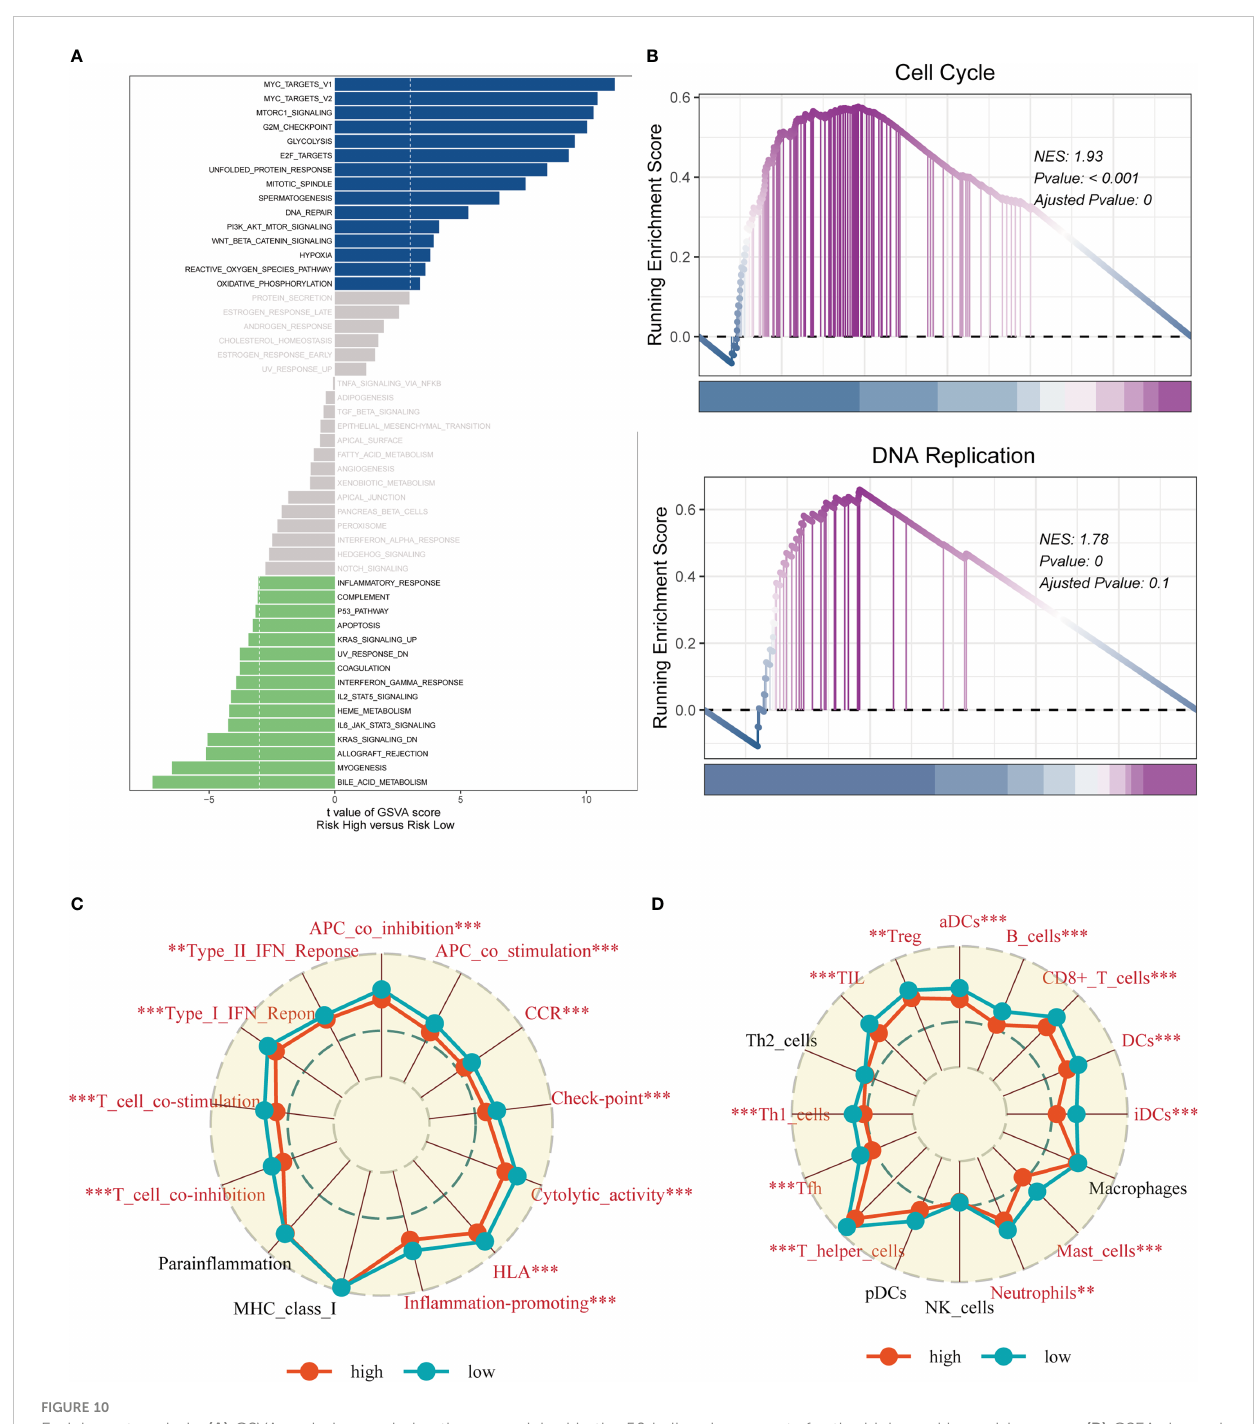
FIGURE 10 Enrichment analysis. (A) GSVA analysis revealed pathways enriched in the 50 hallmark gene sets for the high- and low- risk groups. (B) GSEA showed pathway differences between high- and low-risk groups. (C, D) The ssGSEA algorithm was employed to quantify the immune cell in fi ltration and immune function between the high-risk and low-risk groups. Note: ** P < 0.01, *** P <